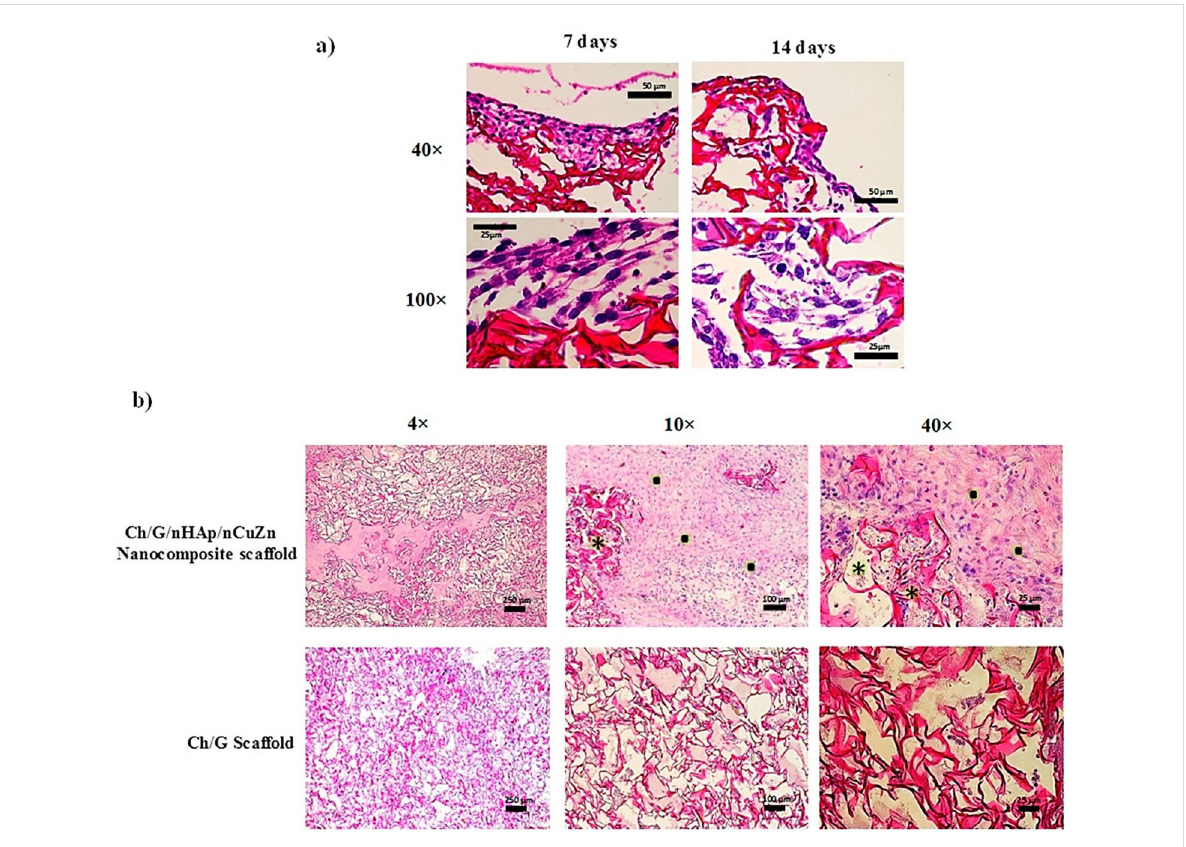
Figure 3: (a) Cross-sectional histological photomicrographs from the chitosan/gelatin/ nanohydroxyapatite/nanocopper/zinc alloy nanocomposite scaf- fold stained with haematoxylin/eosin at seven and 14 days after surgery. (b) Haematoxylin/eosin-stained sections of scaffolds from in vivo biocompati- bility assessments. Figure 3 was reproduced from [107], (© 2017 J. C. Forero et al., published by MDPI, distributed under the terms of the Creative Commons Attribution 4.0 International License,